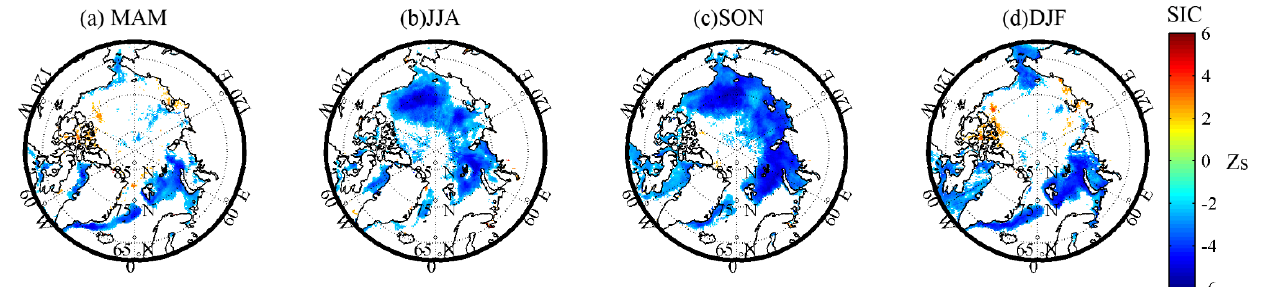
Figure 7. Spatial distributions of Zs derived by the Mann–Kendall test for the SIC over the seas in Arctic (60°~90°N) for different seasons ( a – d ) MAM-DJF from 1987 to 2019. The colored regions are at a significance level of 95%.